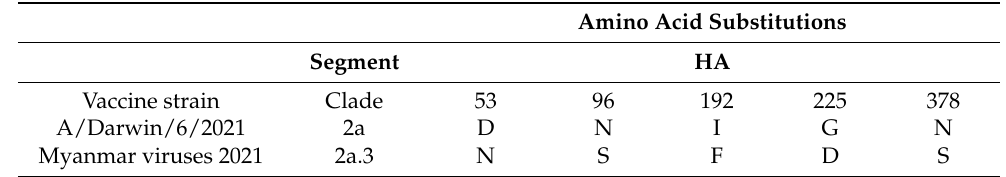
Table 3. Common amino acid substitutions in the HA segment of A(H3N2) viruses collected in Myanmar in 2021 compared with those of the SH 2022 vaccine strain